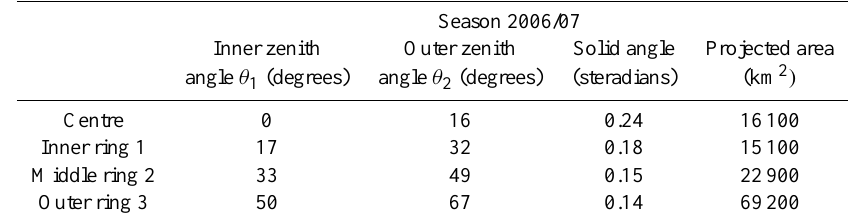
Table 2. A table showing the inner and outer zenith angles for each ring, and the associated solid angles. For the first winter (2006–2007) the SCANDI zones were divided according to equal area on the CCD chip.